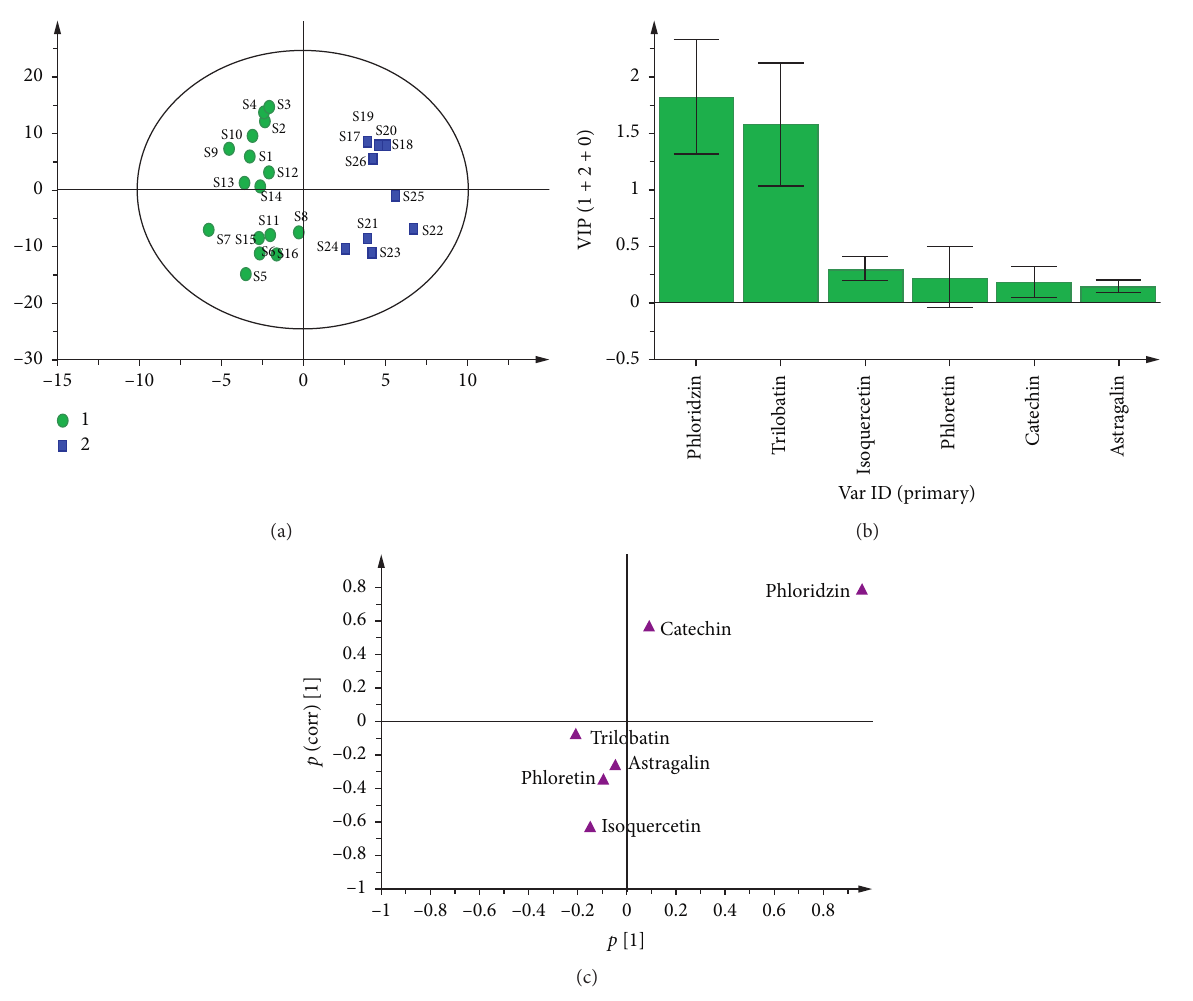
Figure 6: OPLS-DA analysis of the contents of six chemicals of LP samples. (a) OPLS-DA score plot shows distribution of samples into two clusters, series ((1) tender leaf; (2) flower spike). (b) Variable importance for the projection (VIP). (c) An S-plot highlights